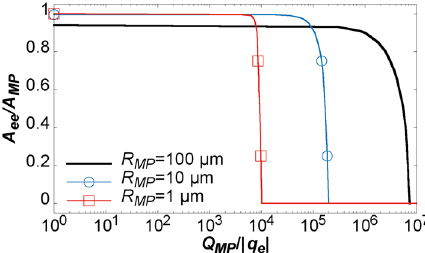
FIG. 9. The escaping coefficient of a secondary electron versus the MP charge number for MPs of different sizes.